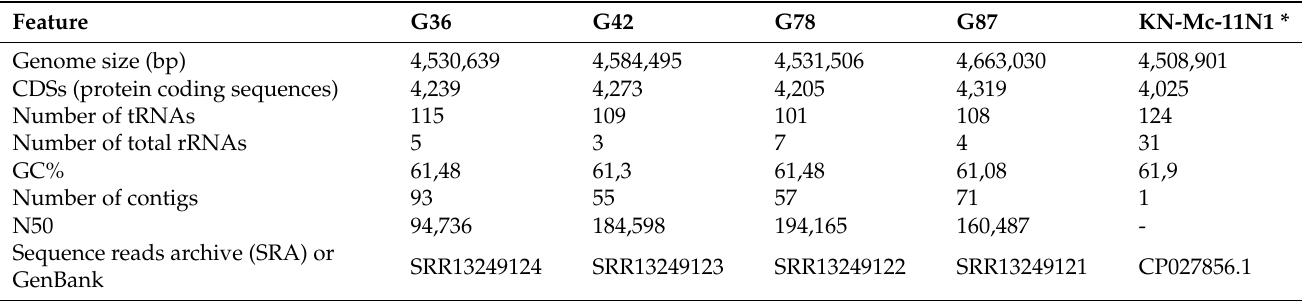
Table 1. Genome features of the sequenced A. rivipollensis strains used in this study compared to KN-Mc-11N1 as a reference strain.